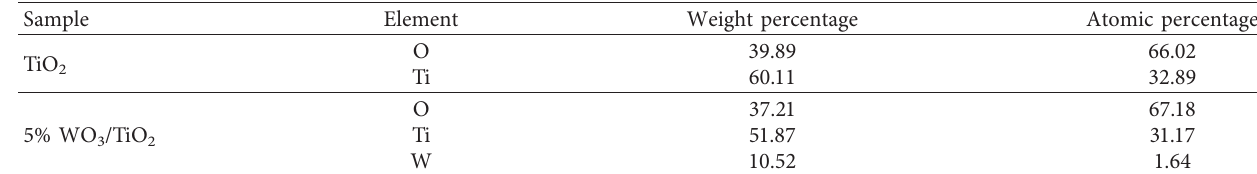
2 and 5% WO 3 /TiO 2 nanofibers.